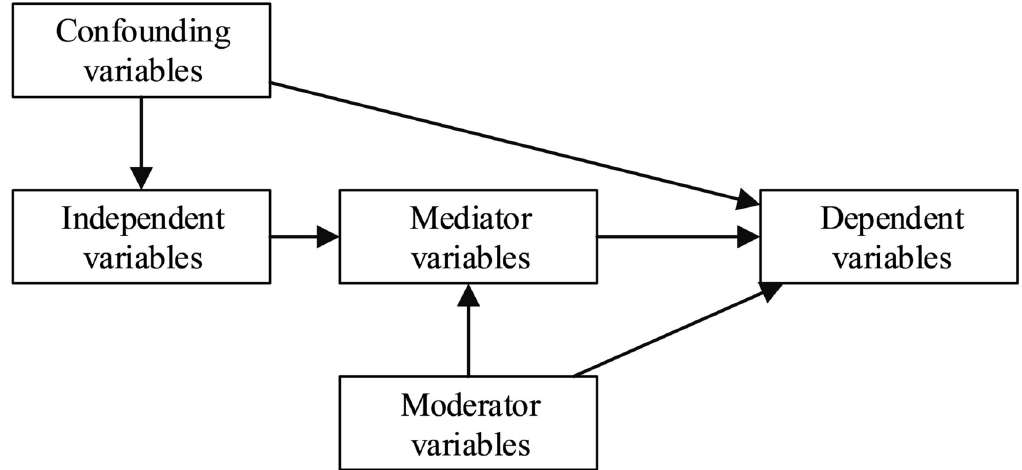
Fig 1. Four categories of variables influencing traffic accidents (Elvik et al.